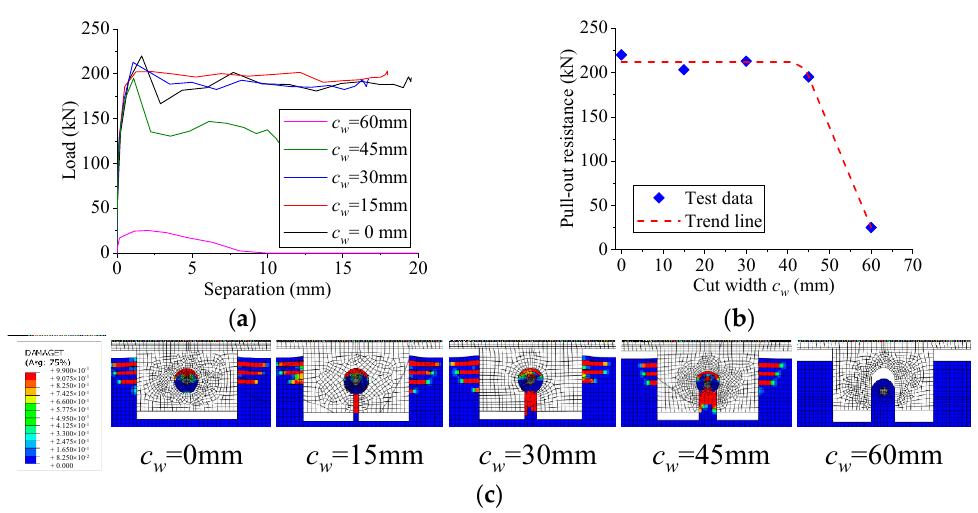
Figure 15. Influence of cut width. ( a ) Load–separation curves; ( b ) influence analysis; ( c ) failure mode.